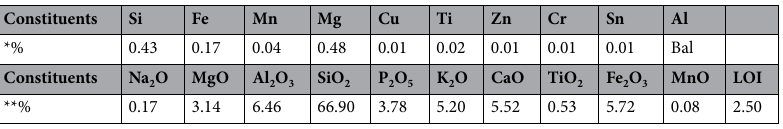
Table 1. Elemental composition of the Al6063 matrix and chemical oxides present in the PKSA. *Al6063 matrix elemental compositions; **Chemical oxides in